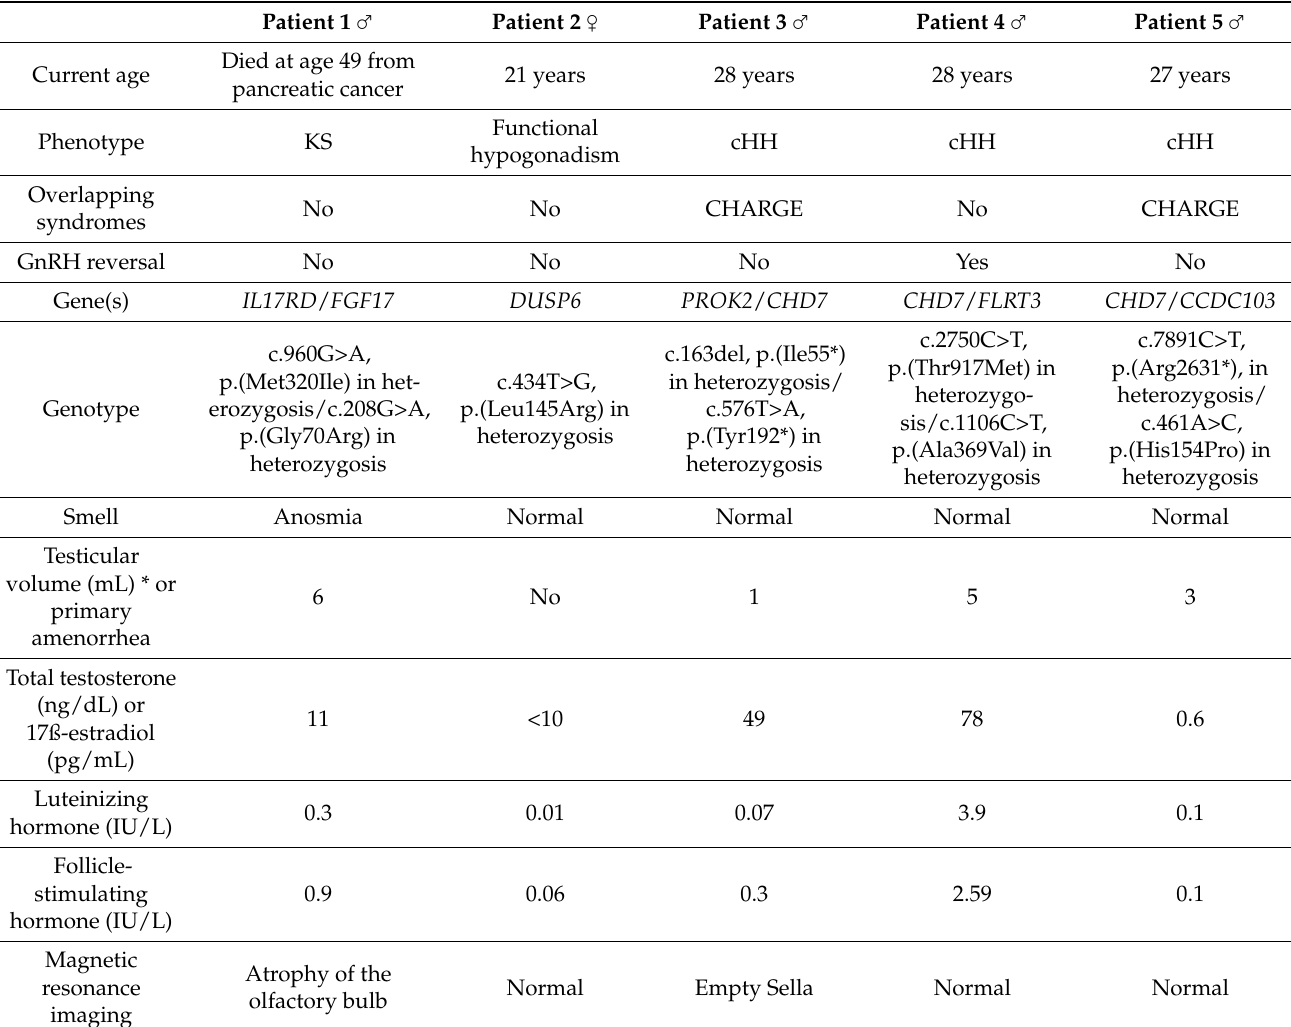
Table 1. Clinical and biochemical features of the patients with congenital hypogonadotropic hypogo- nadism (cHH)/Kallmann syndrome